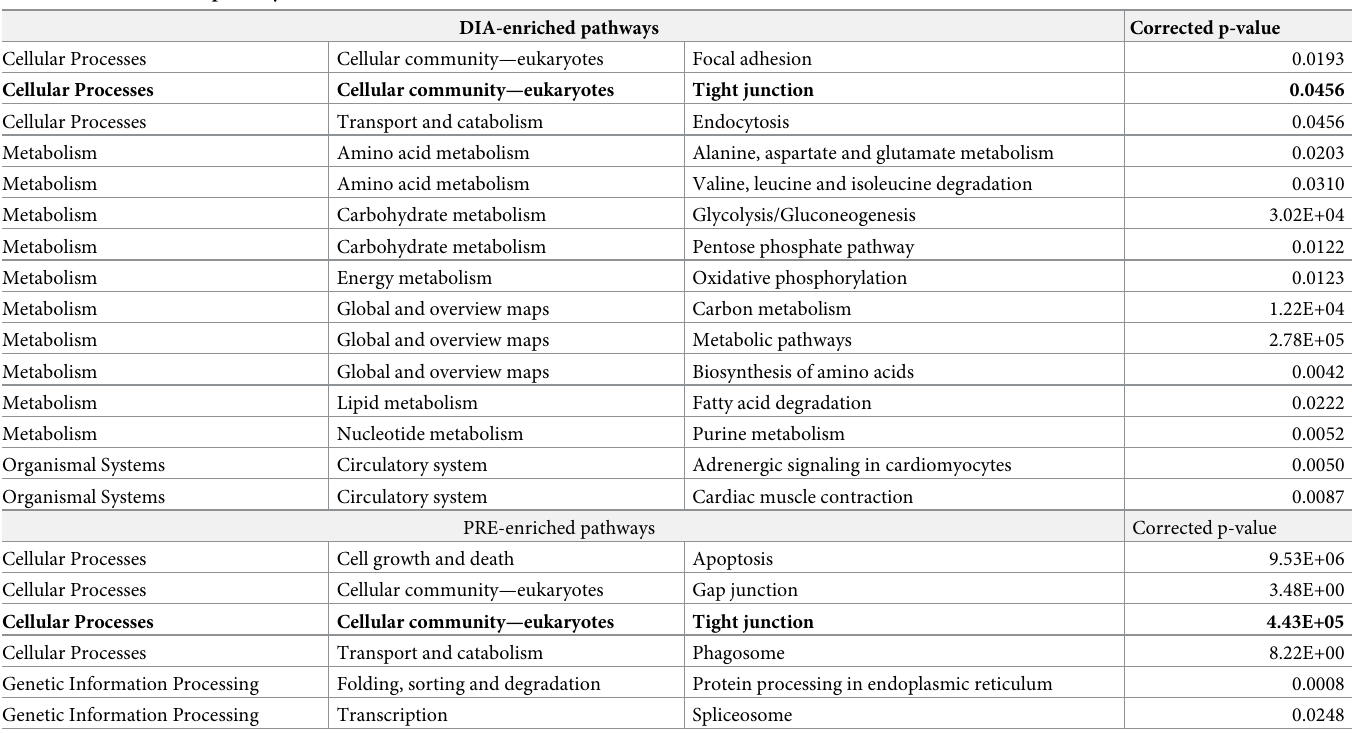
Table 1. KEGG enriched pathways in DIA and